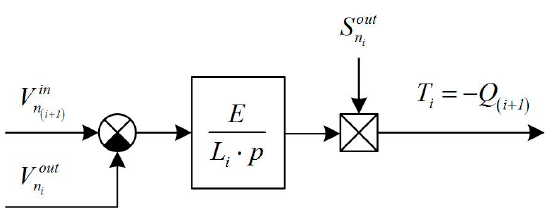
Figure 9. Structural diagram of the Digital Twin of the inter-stand space. According to Figure 3, the mathematical model of the inter-stand space in front of the idle stand must have three input coordinates: the speed and value of the cross-sectional area of the strip at the exit from Stand 1; the tensile force in the feed between Stand 1 and idle stand; and one output coordinate, namely the strip speed at the entry to the idle stand. The elastic deformation of the metal in the inter-stand space is described by the integral